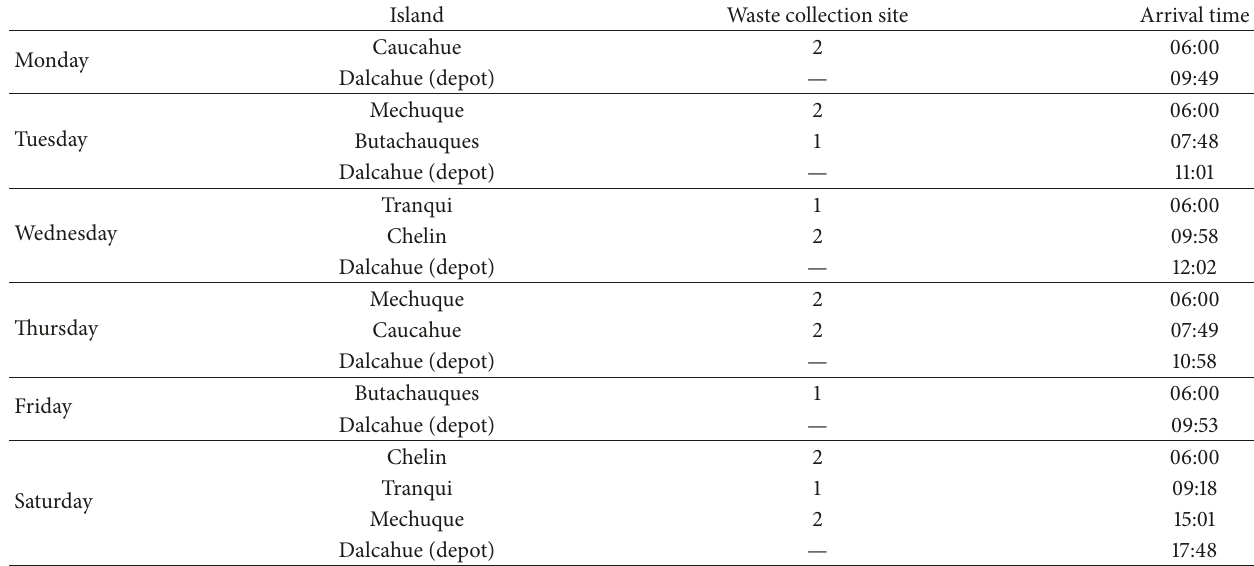
Table 6: Visit sequences and schedule for 𝜀 = 1.3𝐸 + 8 using the epsilon-constraint